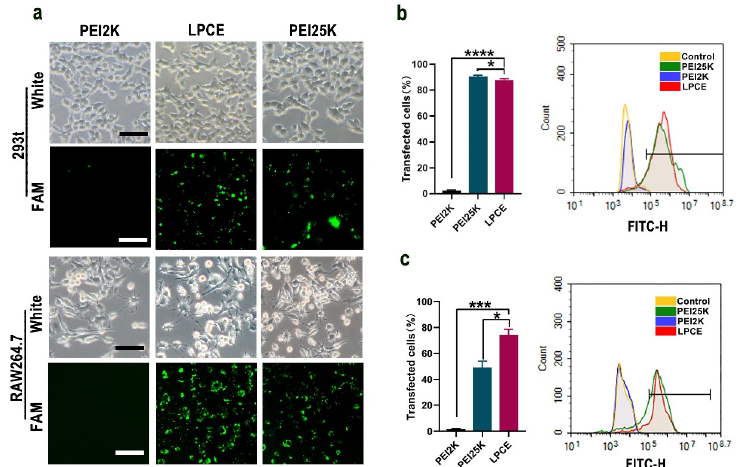
Figure 2. In vitro gene transfection study of LPCE micelle. ( a ) Fluorescence microscopy images of RAW264.7 and 293T cells (scale bar, 100 μ m). FAM is fluorescently labeled siRNA ( b ) Transfection efficiency of LPCE micelle on 293T cells (**** p < 0.0001, * p < 0.05) analyzed by flow cytometry. ( c ) Transfection efficiency of LPCE micelle on RAW264.7 cells (*** p < 0.001, * p < 0.05) analyzed by flow cytometry.